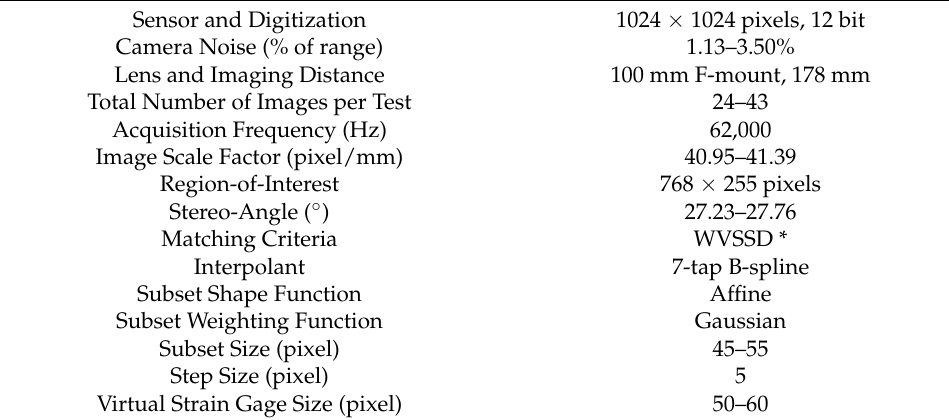
Figure 9. ( a ) Picture of the two-level double-sided calibration plate used to calibrate the pinhole camera model and the heating ring used to illuminate the calibration plate. ( b ) Infrared image of the calibration plate illuminated by the heating ring. Table 2. Stereo Digital Image Correlation